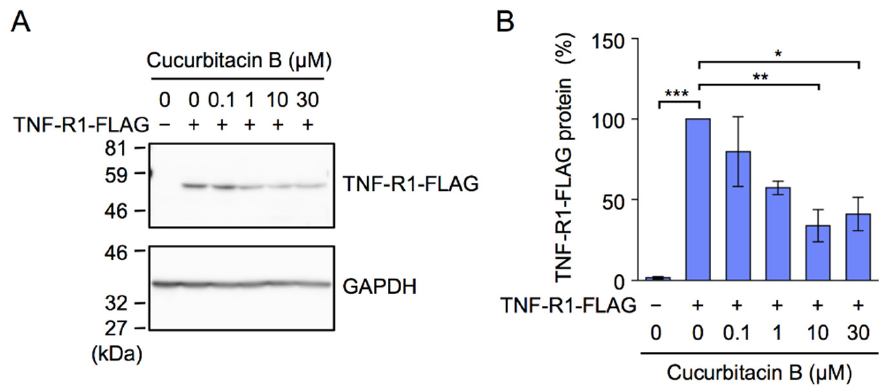
Figure 6. Cucurbitacin B down-regulated the expression of transfected TNF-R1. ( A , B ) A549 cells were transfected with a plasmid vector encoding FLAG-tagged human TNF-R1 for 18 h. Transfected A549 cells were treated with or without cucurbitacin B at the indicated concentrations for 1 h, followed by the preparation of cytoplasmic fractions. Blots are representative of three independent experiments ( A ). The amount of TNF-R1-FLAG was normalized to that of GAPDH. TNF-R1-FLAG protein (%) is shown as mean ± S.E. of three independent experiments ( B ). * p < 0.05, ** p < 0.01, and *** p < 0.001.